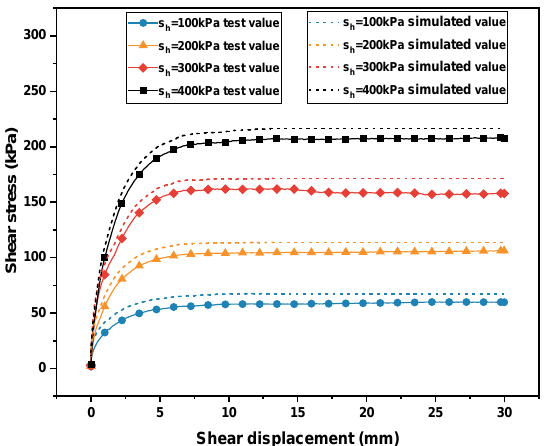
Figure 25. Shear stress–displacement curves of interface static shear simulated values and test values.